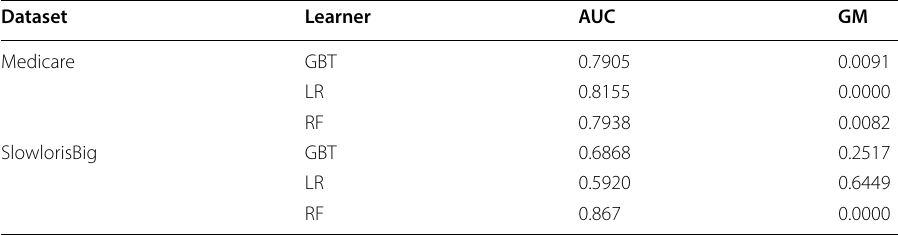
Table 3 No-sampling (all:all) results